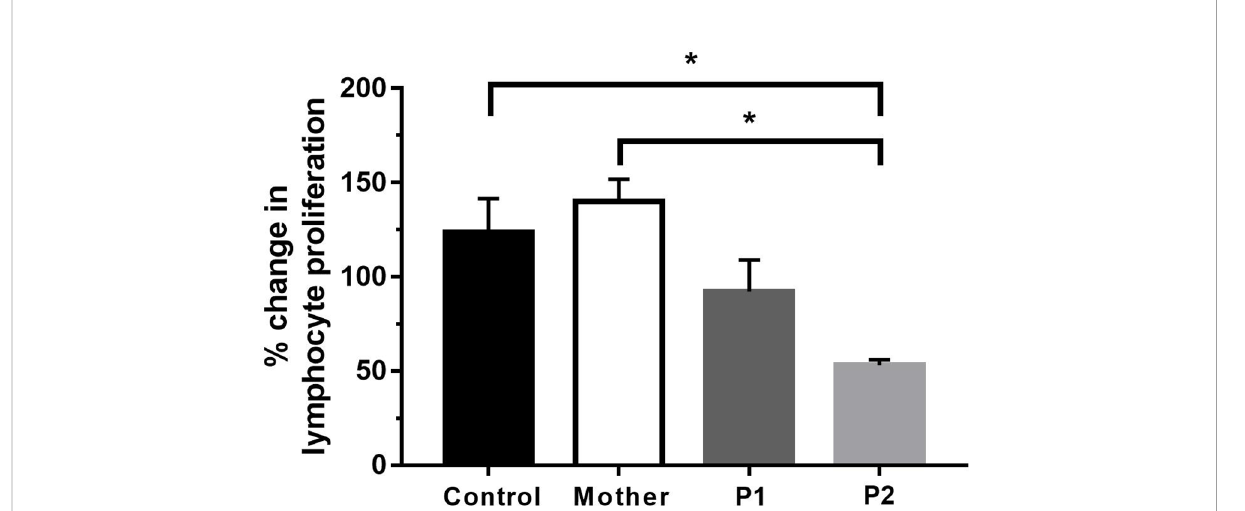
FIGURE 6 Proliferation of lymphocytes after 72 h of PHA activation. Data are the mean ± SEM of three independent experiments. Control represents the results of six healthy volunteers. * p < 0.05 healthy control and mother vs. P2, based on one-way ANOVA followed by Bonferroni ’ s post-hoc test.